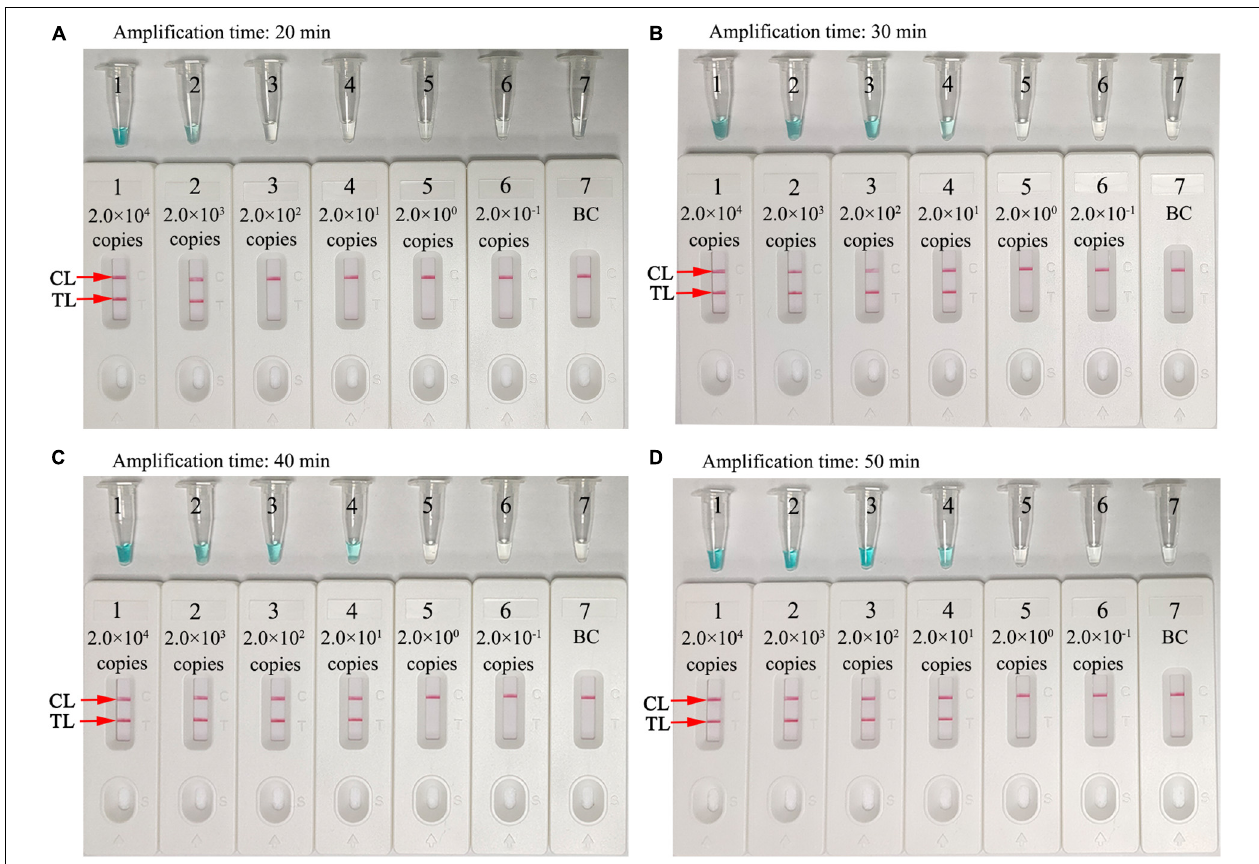
FIGURE 6 | Optimization of assay reaction times. Four different amplification times (A) , 20 min; (B) , 30 min; (C) , 40 min; and (D) , 50 min were tested at 67 ◦ C. Tube/Biosensors 1, 2, 3, 4, 5, 6, and 7 represented N. gonorrhoeae (ATCC 49926) genomic DNA at 2.0 × 10 4 to 2.0 × 10 − 1 copies/reaction and blank control (distilled water). Optimal sensitivity was indicated when the amplification lasted 30 min (B) . CL, control line; T, test line.